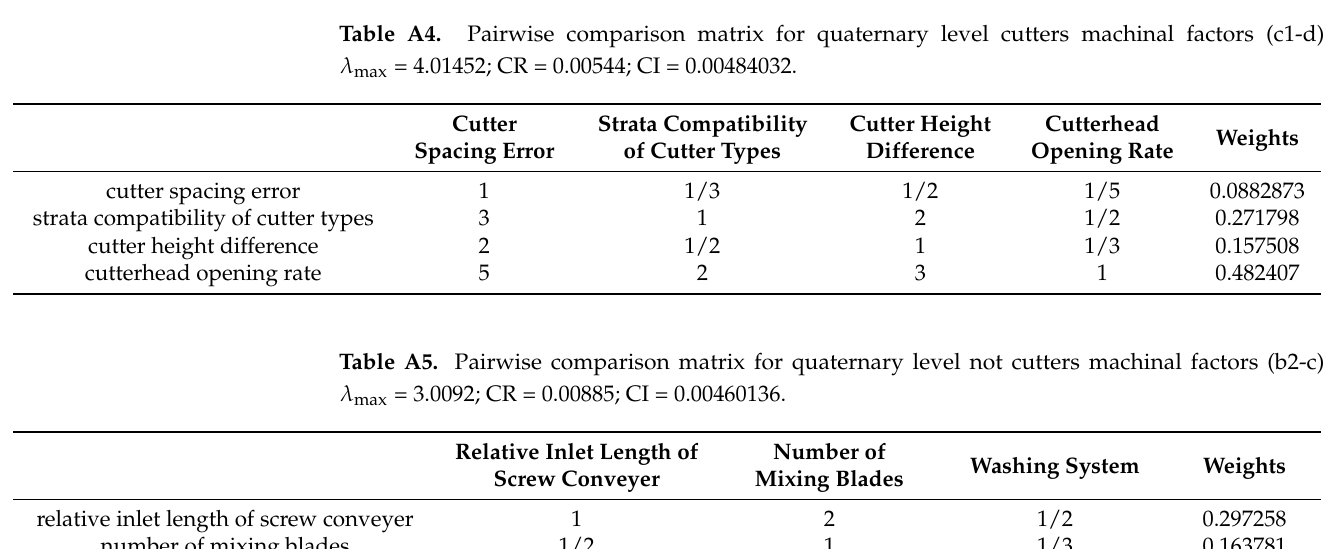
Table A4. Pairwise comparison matrix for quaternary level cutters machinal factors (c1-d)